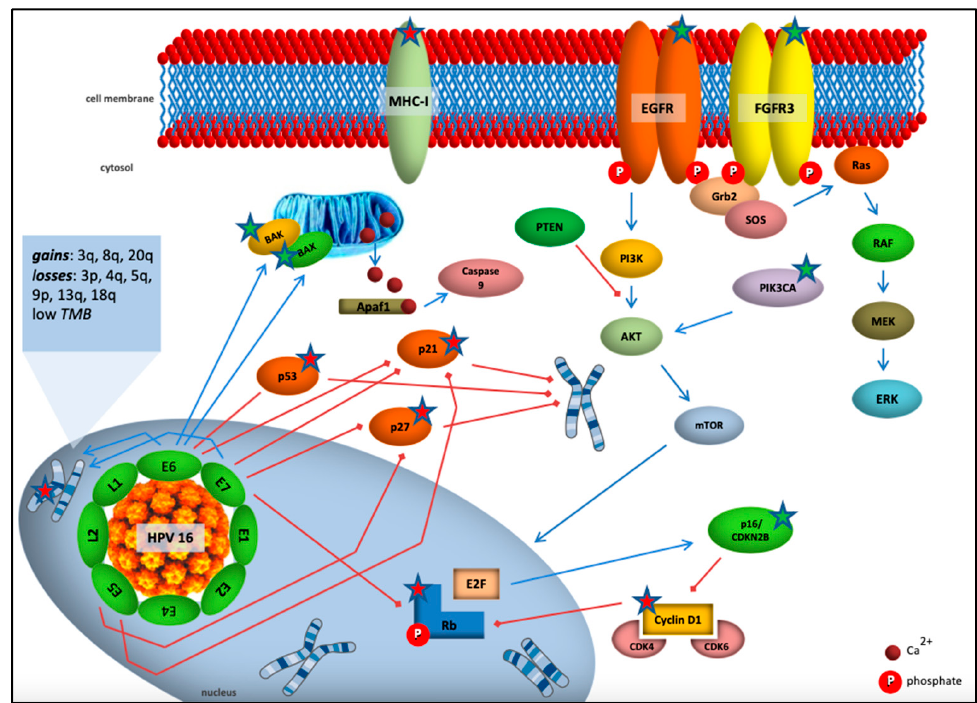
Figure 1. Tumor biology of HPV-driven head and neck squamous cell carcinomas. Increased expression levels are indicated by green stars, red stars indicate decreased expression levels. Blue arrows indicate pathway activation and/or increased expression, respectively. Red arrows indicate pathway inhibition and/or decreased expression, respectively. TMB—tumor mutational burden.